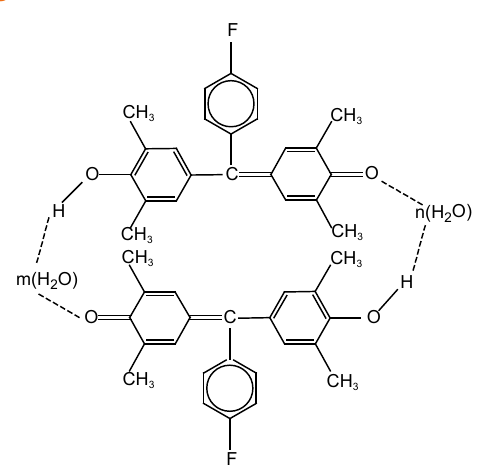
Figure 5. Water catalysis model involving two molecules of 15